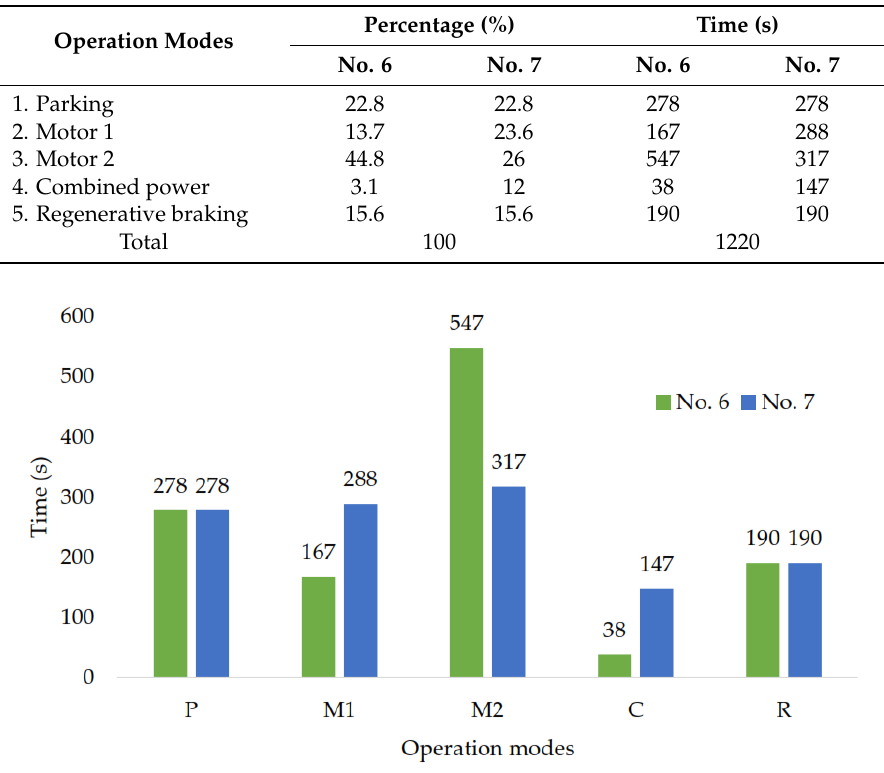
Table 3. The comparison No. 6 and No. 7 for the operation mode selection.